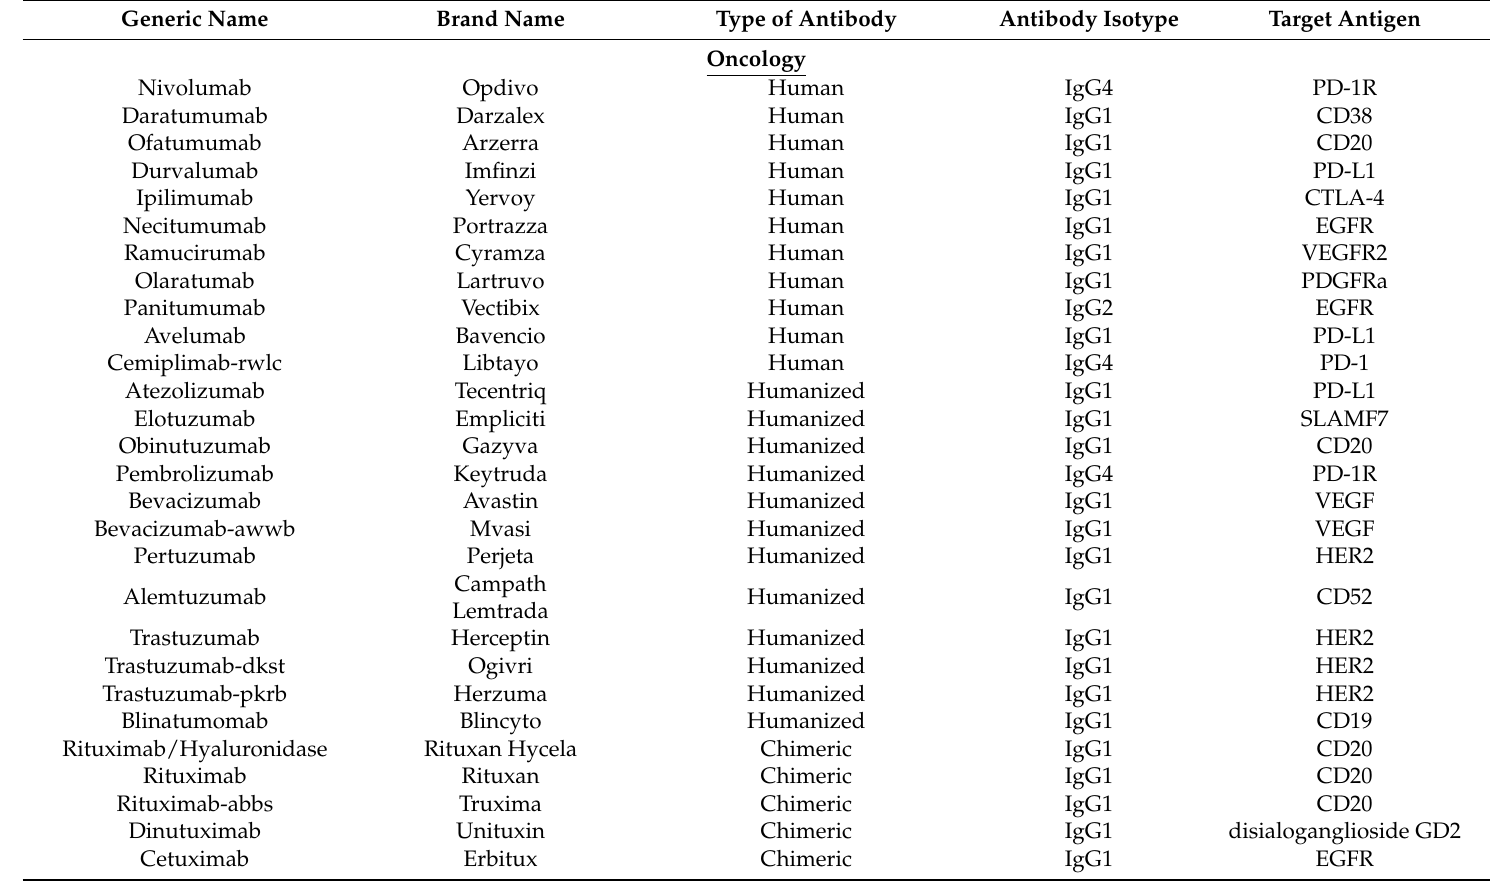
Table 2. FDA-approved, non-conjugated monoclonal antibodies for therapeutic